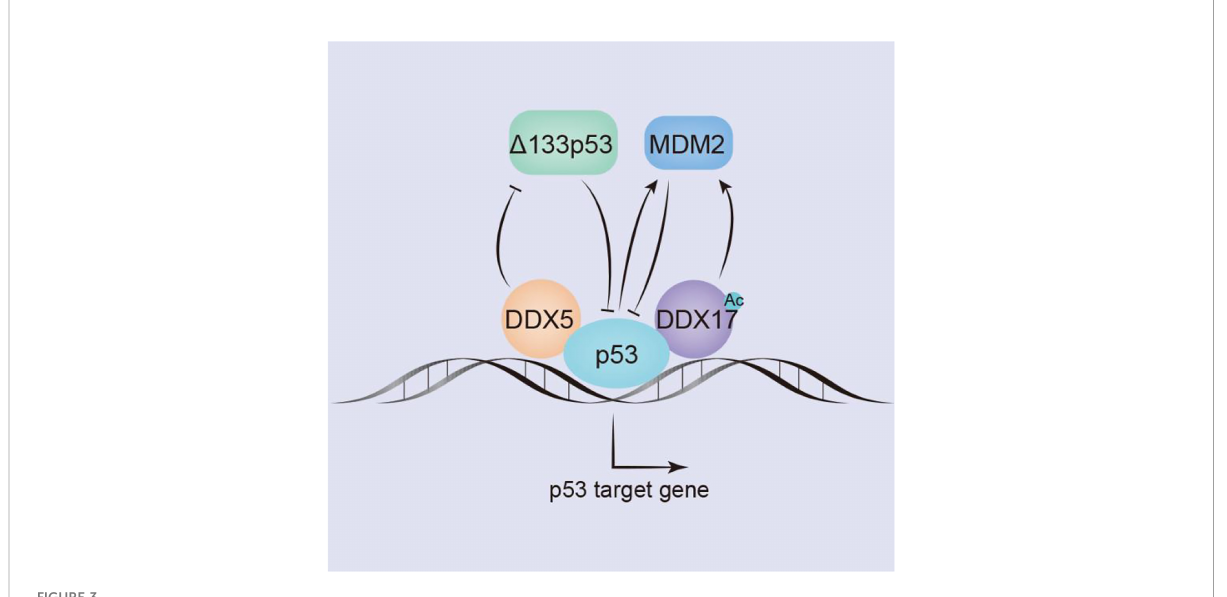
FIGURE 3 DDX5/DDX17 play an extremely important role in the p53 signaling pathway. DDX5/DDX17 are coreguulators of p53, and DDX5 selectively regulates p53 mediation of growth arrest or apoptosis; DDX5 positively regulates the expression of p53 by inhibiting D 133p53. In contrast, DDX17 negatively regulates p53 expression by inducing Mdm2